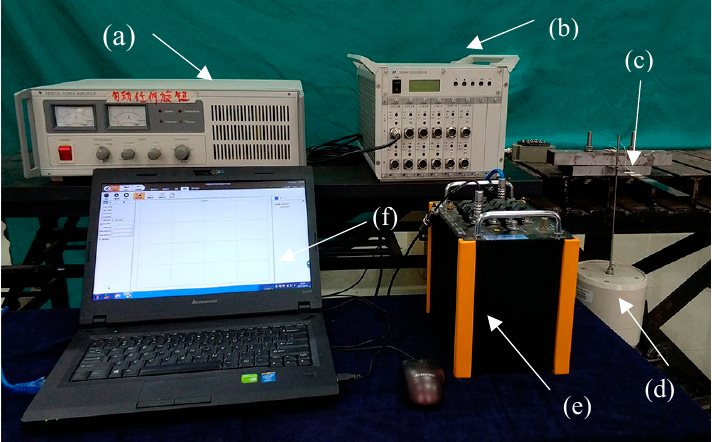
Figure 2. Test specimens of a steel beam bonded with the MFC (M2814-P1) actuator, and a foil strain gauge bonded on the surface of the MFC actuator.